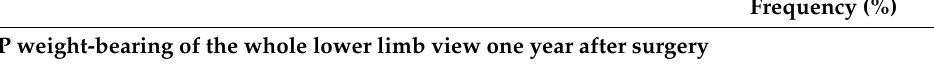
Table 5. Radiographic and follow-up post-operative